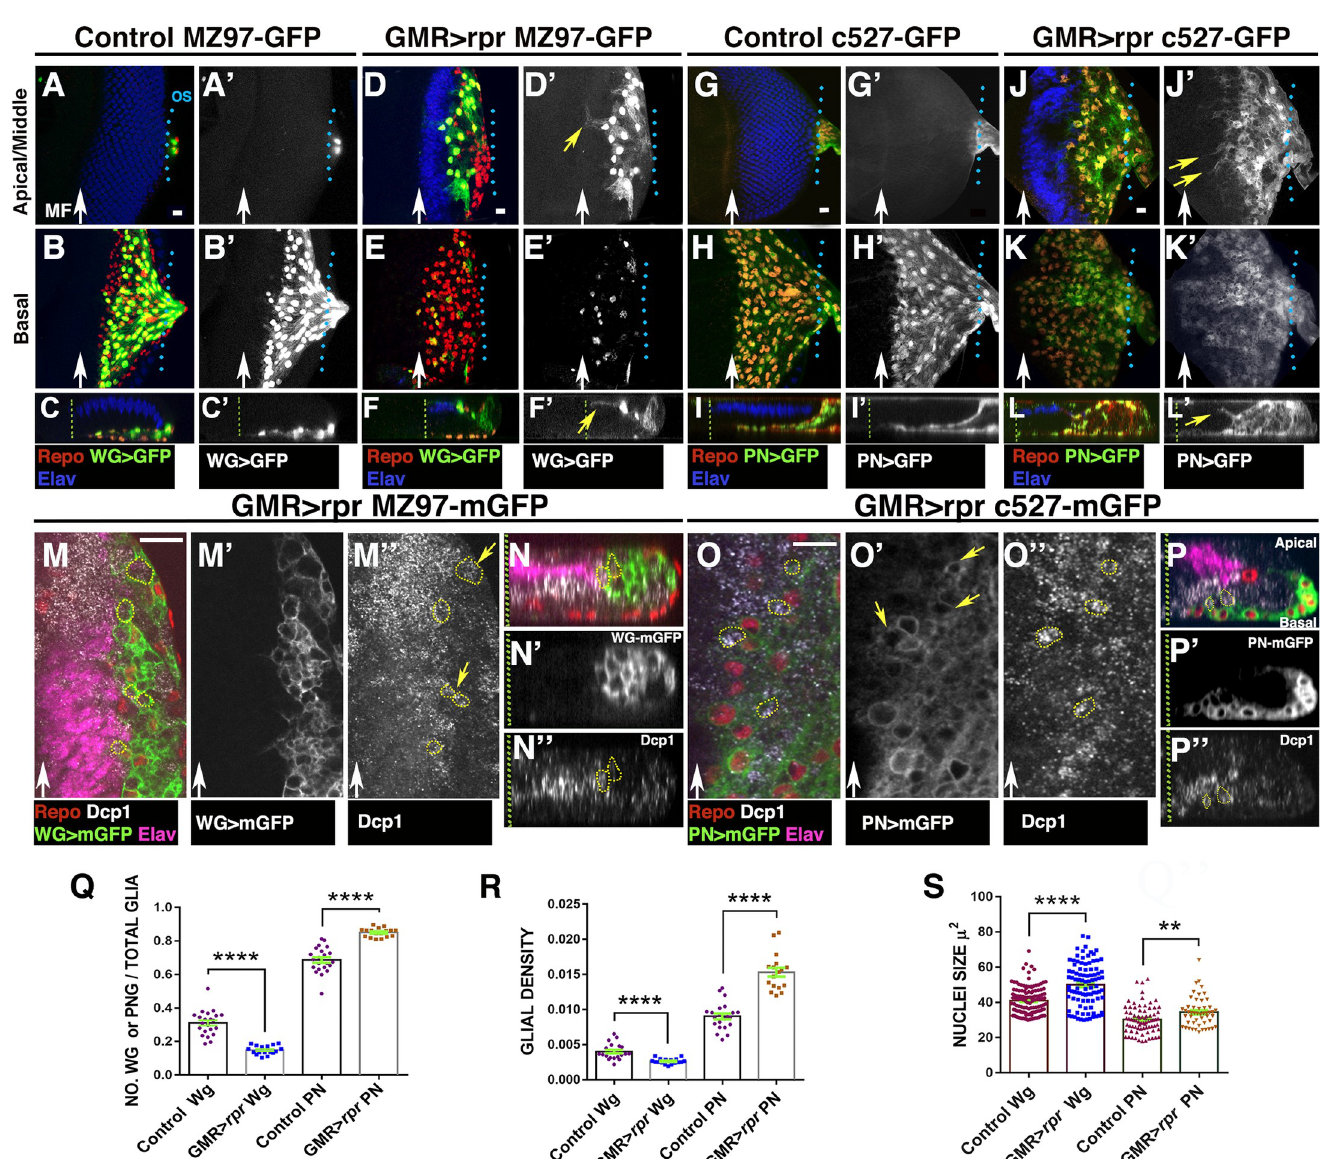
Fig 4. WG and PN cells change their morphology in response to apoptotic induction in the retinal region. (A–L) Third instar eye discs stained with anti-Elav (blue) and anti-Repo (red). (A–F’) Mz97-Gal4 driving expression of UAS-GFP (green A–C and D–F and grey A’–C’ and D’–F’) reveals WG cells in control UAS-GFP Mz97-Gal4; QUAS-rpr (A–C’) and in damaged GMR-QF; UAS-GFP Mz97-Gal4; QUAS-rpr (D–F’) discs. (G–L’) c527-Gal4 drives expression of UAS-GFP (green G–I and J–L and grey in G’–I’, J’–L’) in PN glial cells in control UAS-GFP c527-Gal4; QUAS-rpr (G–I’) and damaged GMR-QF; UAS-GFP c527-Gal4; QUAS-rpr eye discs (J–L’). (A–A’, D–D’, G–G’, and J–J’) Apical/middle layers and (B–B’, E–E’, H–H,’ and K–K’) basal layers of the eye disc epithelium. (C–C’, F–F’, I–I’, and L–L’) Orthogonal section perpendicular to the furrow through confocal stacks of the eye discs shown in A–K’. (A–F’) In control discs, we never find WG cells in the middle or apical layer of the discs (A–C’); however, in damaged discs, most WG cells are located in the apical region (D–F’ yellow arrow in F’). These cells extend large processes towards the damaged region (D–D’ and F–F’). Some of these projections go over photoreceptors (yellow arrow in F’). (G–L’) In damaged eye discs, some PN glial cells were located in the middle layers of the disc epithelium (compared J–L’ with control G–I’), and they send cellular projections towards the damage region (yellow arrows in J’ and L’). (M–P”) Third instar eye discs stained with anti-Elav (magenta), anti-Repo (red), and anti-Dcp-1 (grey). (M–N”) Mz97-Gal4 driving expression of UAS-mCD8-GFP (in green and grey in M’) reveals WG cells in damaged GMR-QF; UAS-mCD8-GFP Mz97-Gal4; QUAS-rpr discs. (O–P”) Damaged GMR-QF; UAS-mCD8-GFP c527-Gal4; QUAS-rpr eye discs showing the membranes of PN glial cells. Both glial cell types (WG and PN) have vesicles containing cellular debris labelled with anti-Dcp1 (yellow arrows in M” in WG and in O” in PN). (Q-S) Graphs showing ratio of WG and PN glial cells (number WG or PN glial cells/number Total glia) (Q), WG and PN glial density (R), and nuclei size (S). Scale bars, 10 μ m. Statistical analysis is shown in Table D in S1 Text. The numerical data used in this figure are included in S1 Data. GMR, glass multiple reporter; PN, perineurial; rpr , reaper ; WG, wrapping glia.